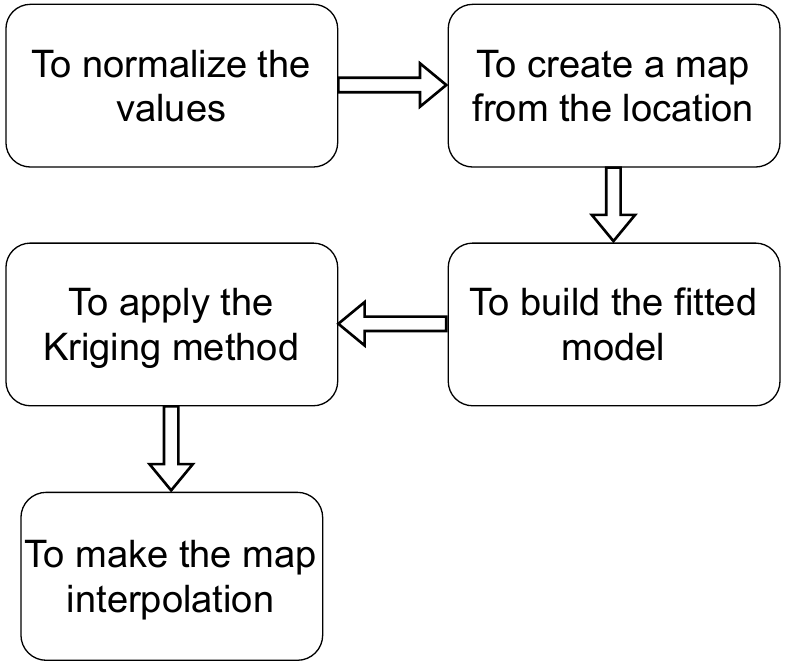
Figure 2. A systematic way that we use to apply the Kriging interpolation on the IoT